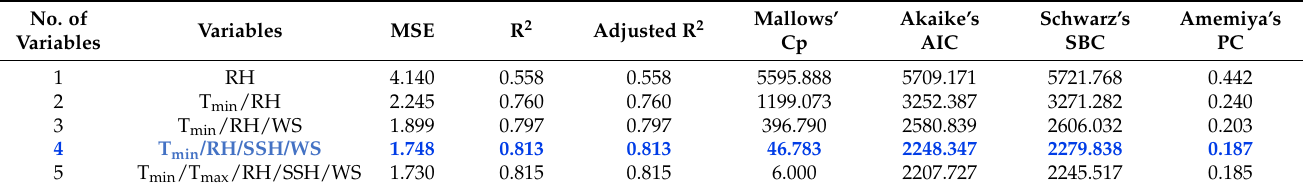
Table 3. The best subset regression analysis for determining the best input combinations at the New Delhi station. No. of Variables